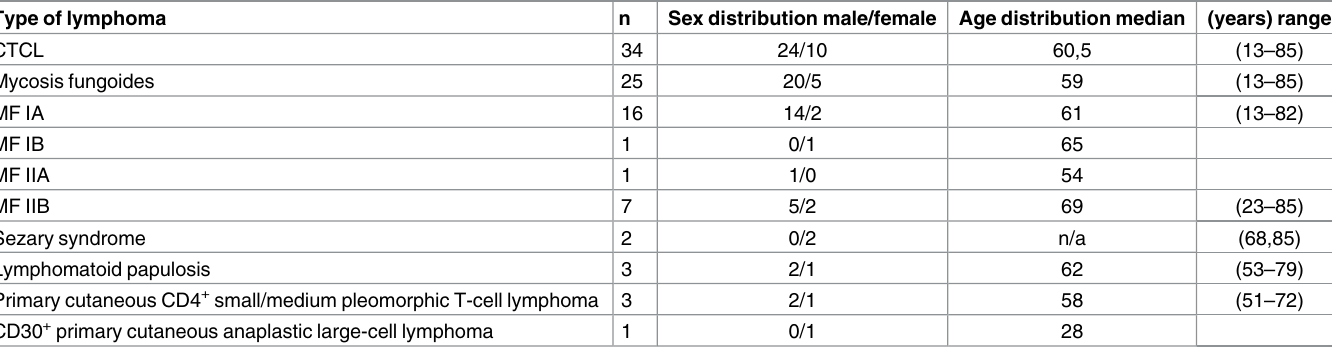
Table 1. Demographic data of 34 primary cutaneous T-cell lymphoma